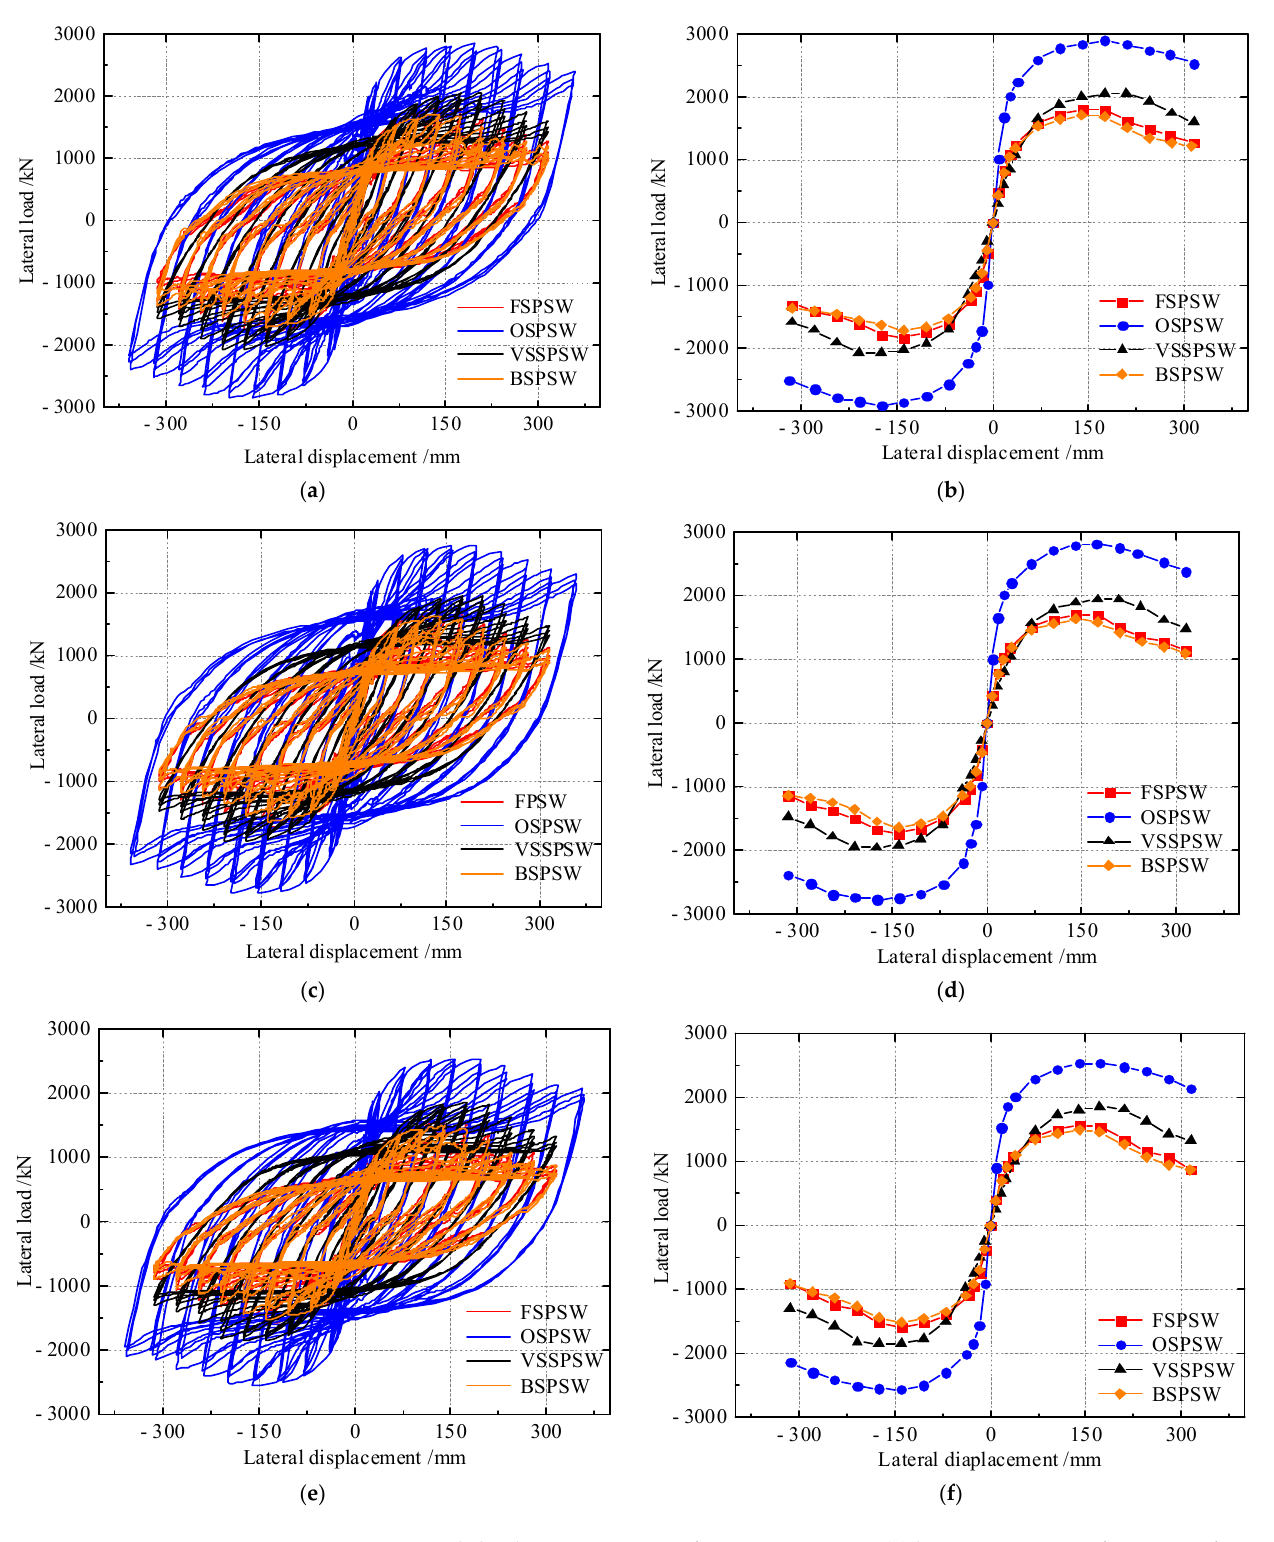
Figure 13. Load ‒ displacement curves of corrosion SPSWs: ( a ) hysteretic curves of corrosion for 20 d; ( b ) envelope curves of corrosion for 20 d; ( c ) hysteretic curves of corrosion for 60 d; ( d ) envelope curves of corrosion for 60 d; ( e ) hysteretic curves of corrosion for 120 d; ( f ) envelope curves of corrosion for 120 d.